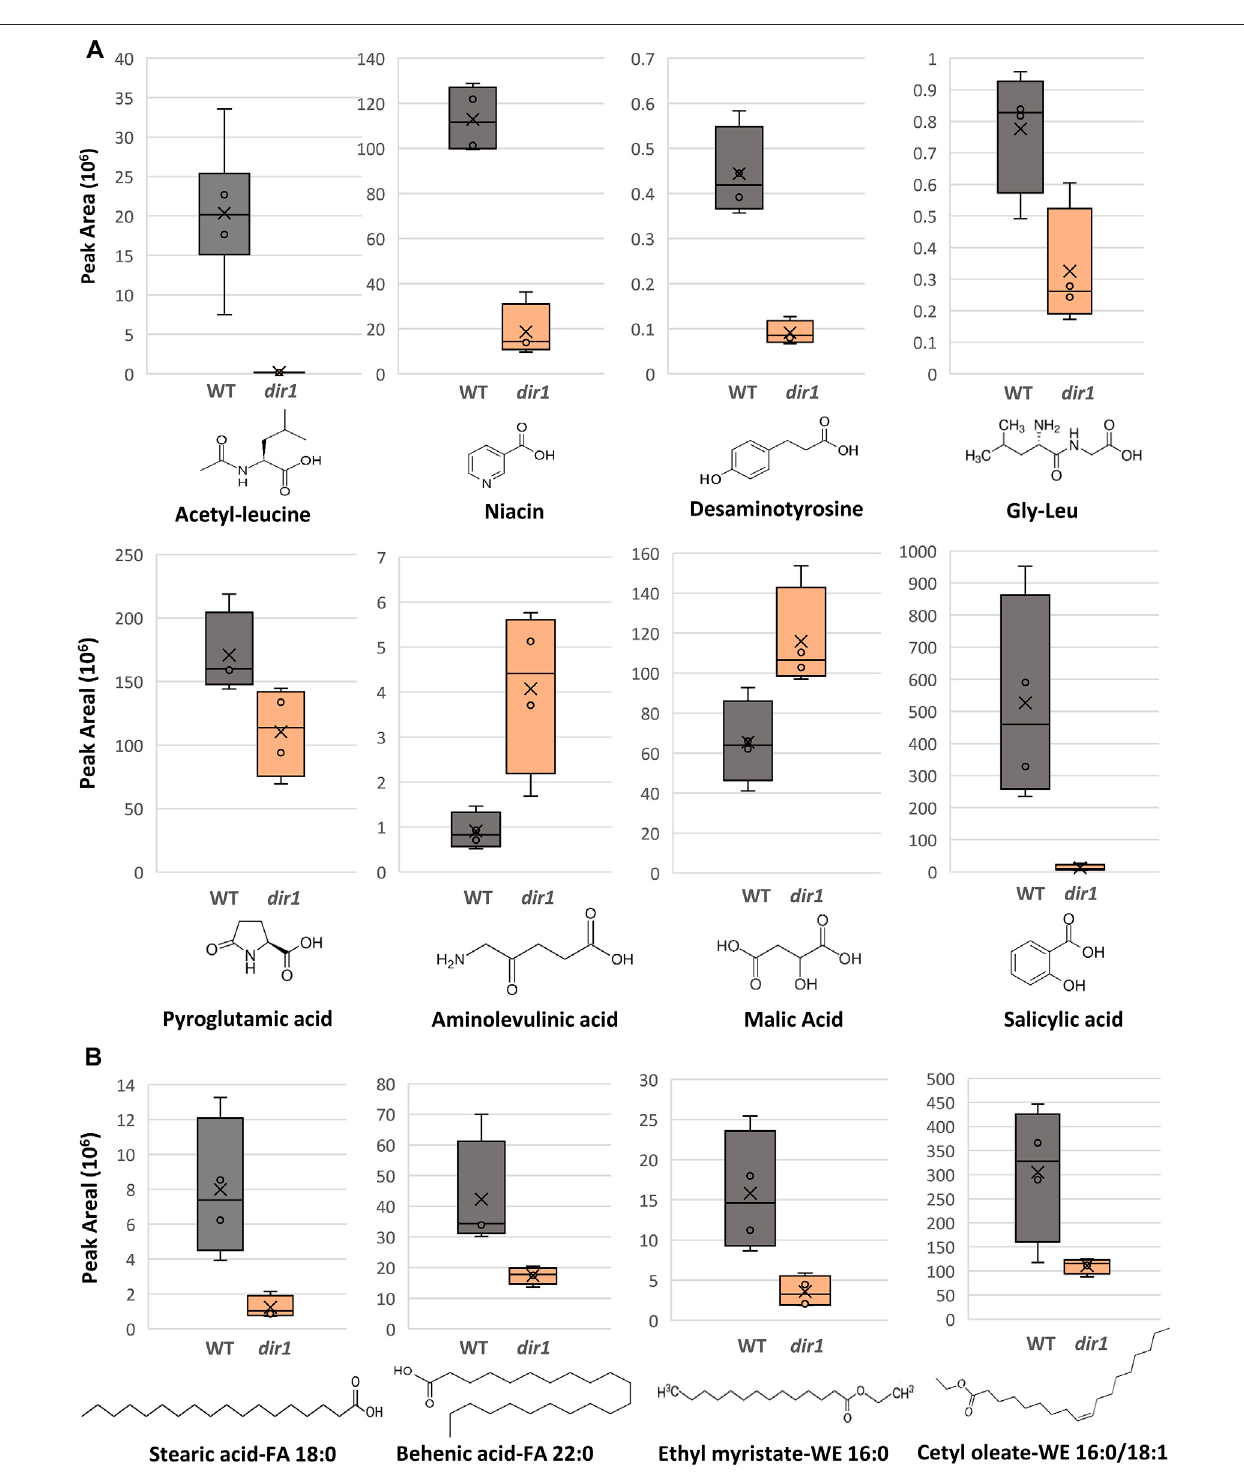
FIGURE 4 | Differentially abundant metabolites identi fi ed in dir1-1 and Pst -primed guard cells. (A) . Box plots showing decreases of acetylleucine, niacin, desaminotyrosine, gly-leu, pyroglutamicacid, and salicylic acid, as well as increases aminolevulinic acid and of malic acid in dir1-1 versusWT guard cells. The error bars are standard deviation of the mean. (B) . Box plots showing decreases of two long-chain fatty acids, stearic acid (FA 18:0) and behenic acid (FA 22:0), and two wax esters,cetyloleate(WE16:0/18:1)andethylmyristate(WE16:0)decreased > 2-foldinthe dir1-1 versusWTguardcells.Chemicalstructures ofstearicacid(FA18: 0), behenic acid (FA 22:0), cetyl oleate (WE 16:0/18:1), and ethyl myristate (WE 16:0) are shown.